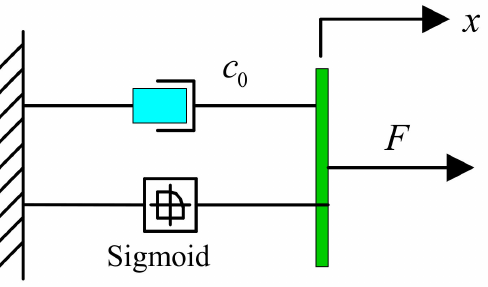
Figure 10. Schematic diagram of adjustable sigmoid